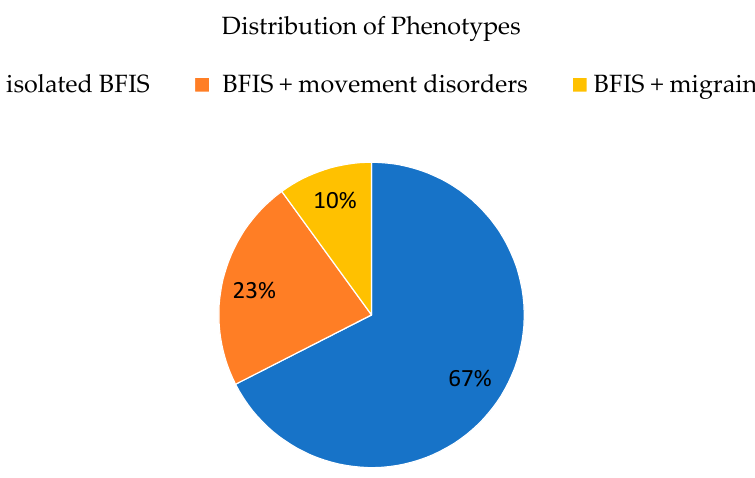
Table 2. Genetic variants of 40 index cases (core cohort) and familial cases from the extended cohort. Index (n) Family (n) Gene (Coding DNA) Protein